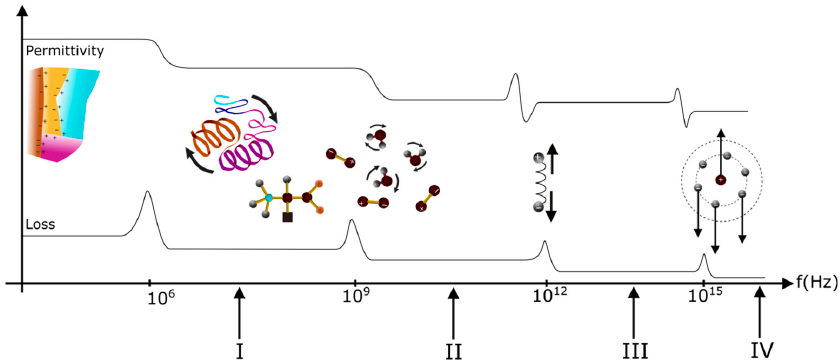
Figure 3. Influence of different types of polarization on dielectric parameters: I, radio frequency range; II, microwave frequency range; III, infrared-visible frequency range; and IV, ultraviolet frequency range.